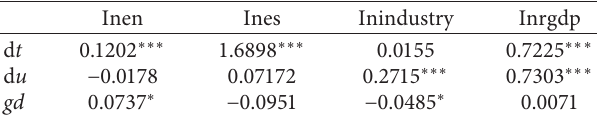
Table 4: Mechanism test of sustainable development pilot zone. Inen Ines